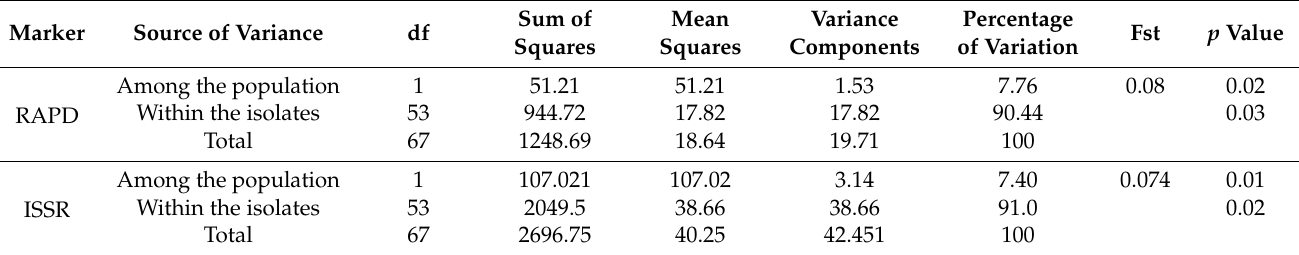
Table 7. Summary of analysis of molecular variance (AMOVA) based on RAPD and ISSR of T. indica